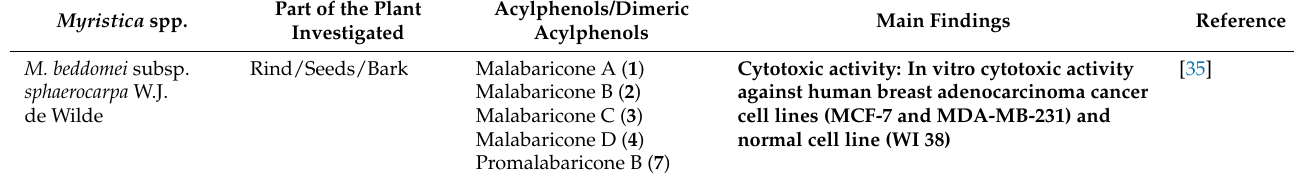
Table 5. The antiproliferative and cytotoxic activities of acylphenols and dimeric acylphenols from the genus Myristica